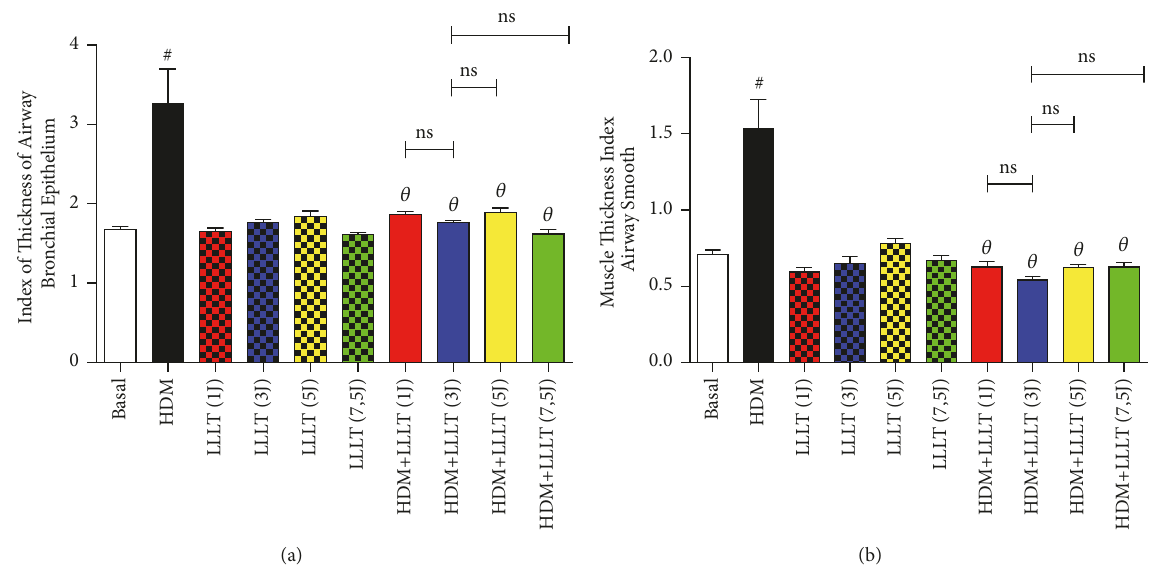
Figure 7: Effect of LLLT on bronchial thickening and airway smooth muscle thickening. The lungs were fixed, prepared and stained with HE for the above analyzes. Increase of × 400. Values expressed as mean and standard deviation. The groups used in the experiment are described in Figure 1. The results refer to the use of 10 mice in each experimental group. # p < 0.001 when compared to the Basal group and 𝜃 p < 0.001 whencompared to theasthmatic group (HDM)and ns (not significant) whencompared HDM+LLLT (3J)group with the othergroups treated with other